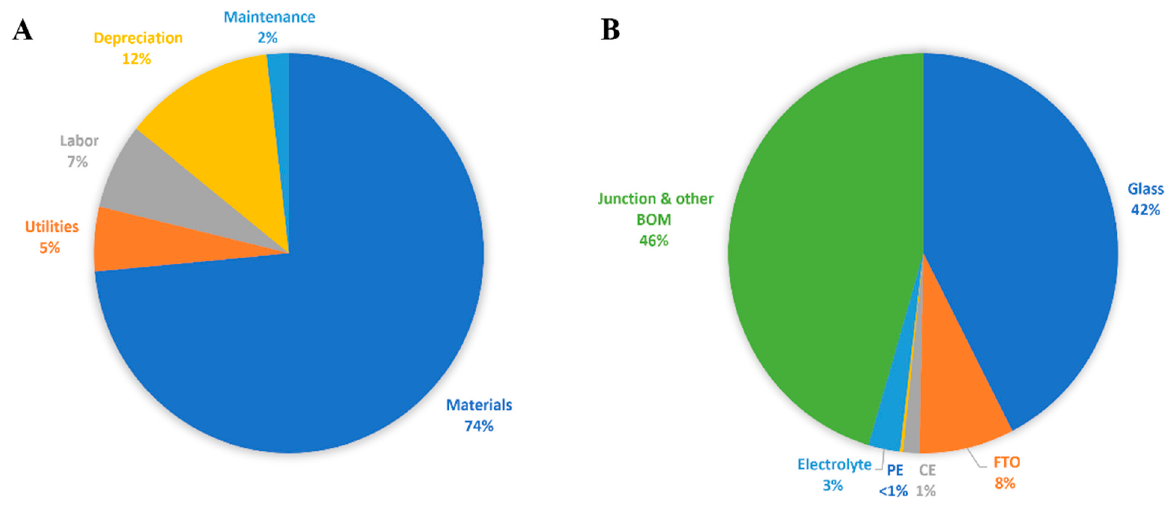
Figure 2. ( A ) Direct manufacturing cost distribution and ( B ) materials cost breakdown of the reference module with a total manufacturing cost of USD 22.4 per m 2 .